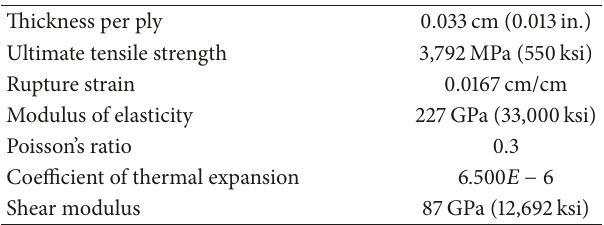
Table 1: Material properties for FRP wraps [7]. Table 2: Data matrix for pier